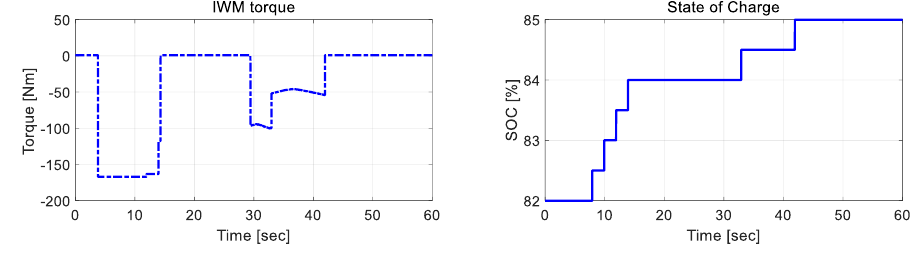
Figure 5. State of charge of the IWM battery during regeneration